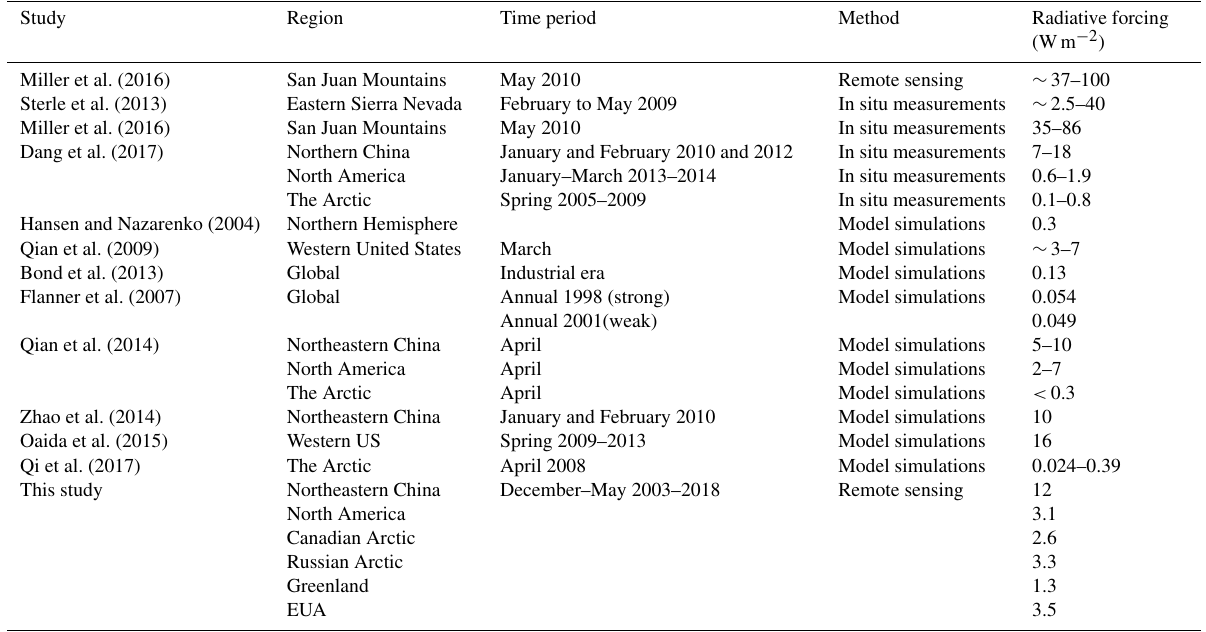
Table 2. Comparisons of radiative forcing due to LAPs in snow (this study) with observed and model-simulated values from previous studies.